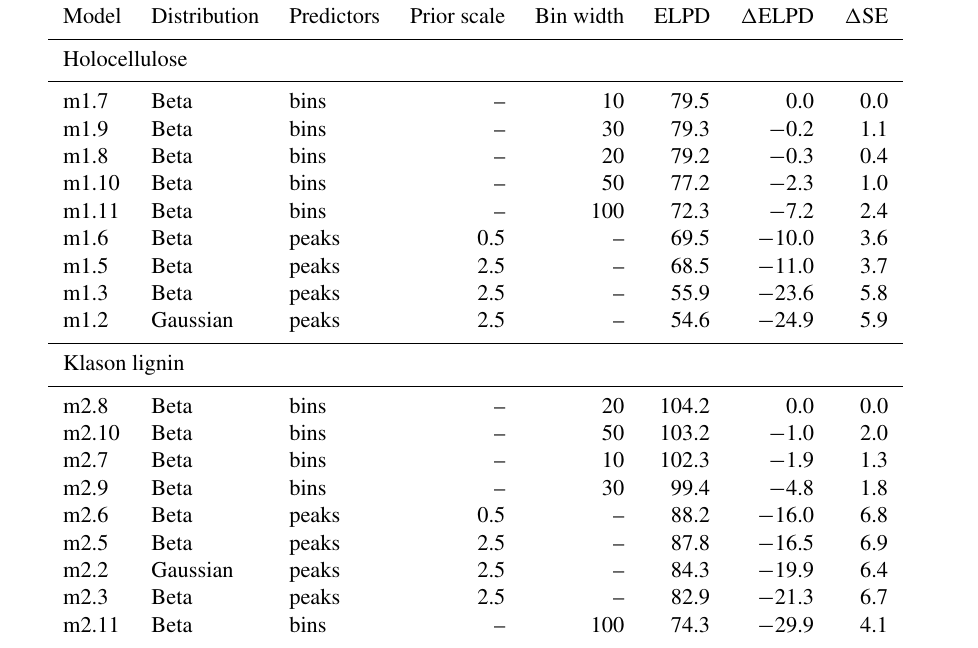
Table 1. Overview on the relative predictive performance of the models for holocellulose and Klason lignin content as measured using PSIS- LOO ELPD. For each variable, the model with the best average predictive performance (largest ELPD) is at the top and the other models follow in descending order. Models ending in “.2” and “.3” are the models with the original model structure as developed by Hodgkins et al. (2018). “Distribution” is the distribution assumed for the target variable. “Predictors” indicates if models were fitted with peaks extracted using the procedure of Hodgkins et al. (2018) (“peaks”) or using binned spectra (“bins”). “Prior” scale indicates the standard deviation for Gaussian coefficients (numeric values) or regularized horseshoe priors were used (“–”). “Bin width” is the width of bins (in wavenumber units). “ELPD” is the PSIS-LOO expected log-predictive density, (cid:49) ELPD the difference in ELPD relative to the average ELPD of